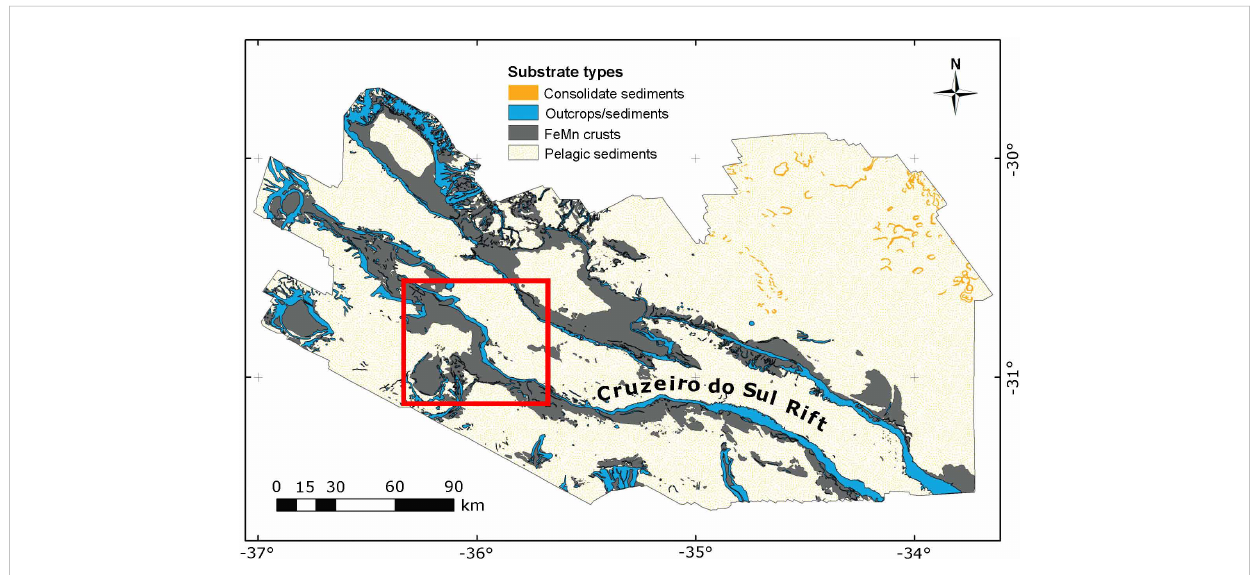
FIGURE 1 Map of the substrate types presented in the western portion of the RGR. In red is highlighted the study area location (modi fi ed by Lisniowski et al.,